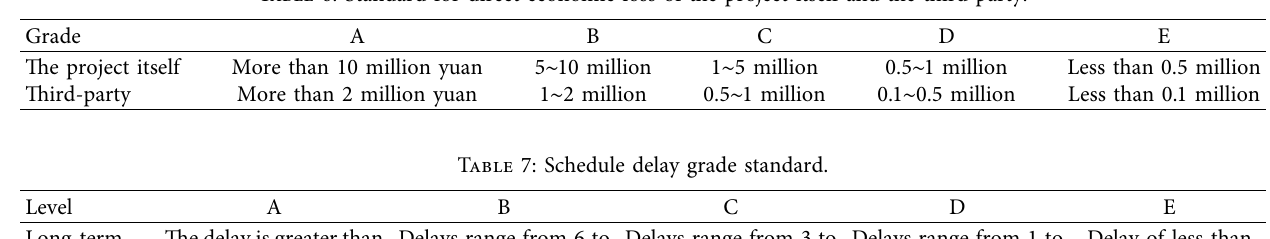
Table 6: Standard for direct economic loss of the project itself and the third party.